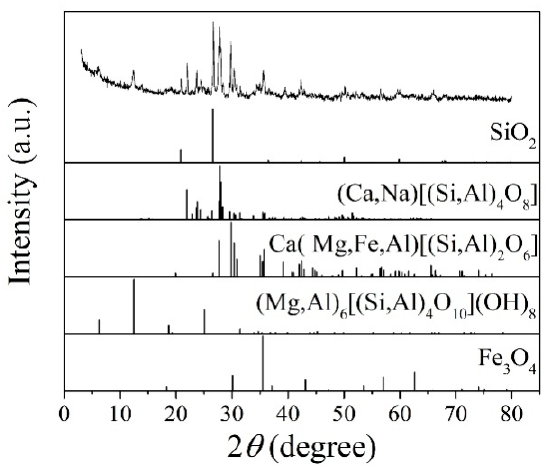
Figure 1. XRD patterns of the basalt rocks.